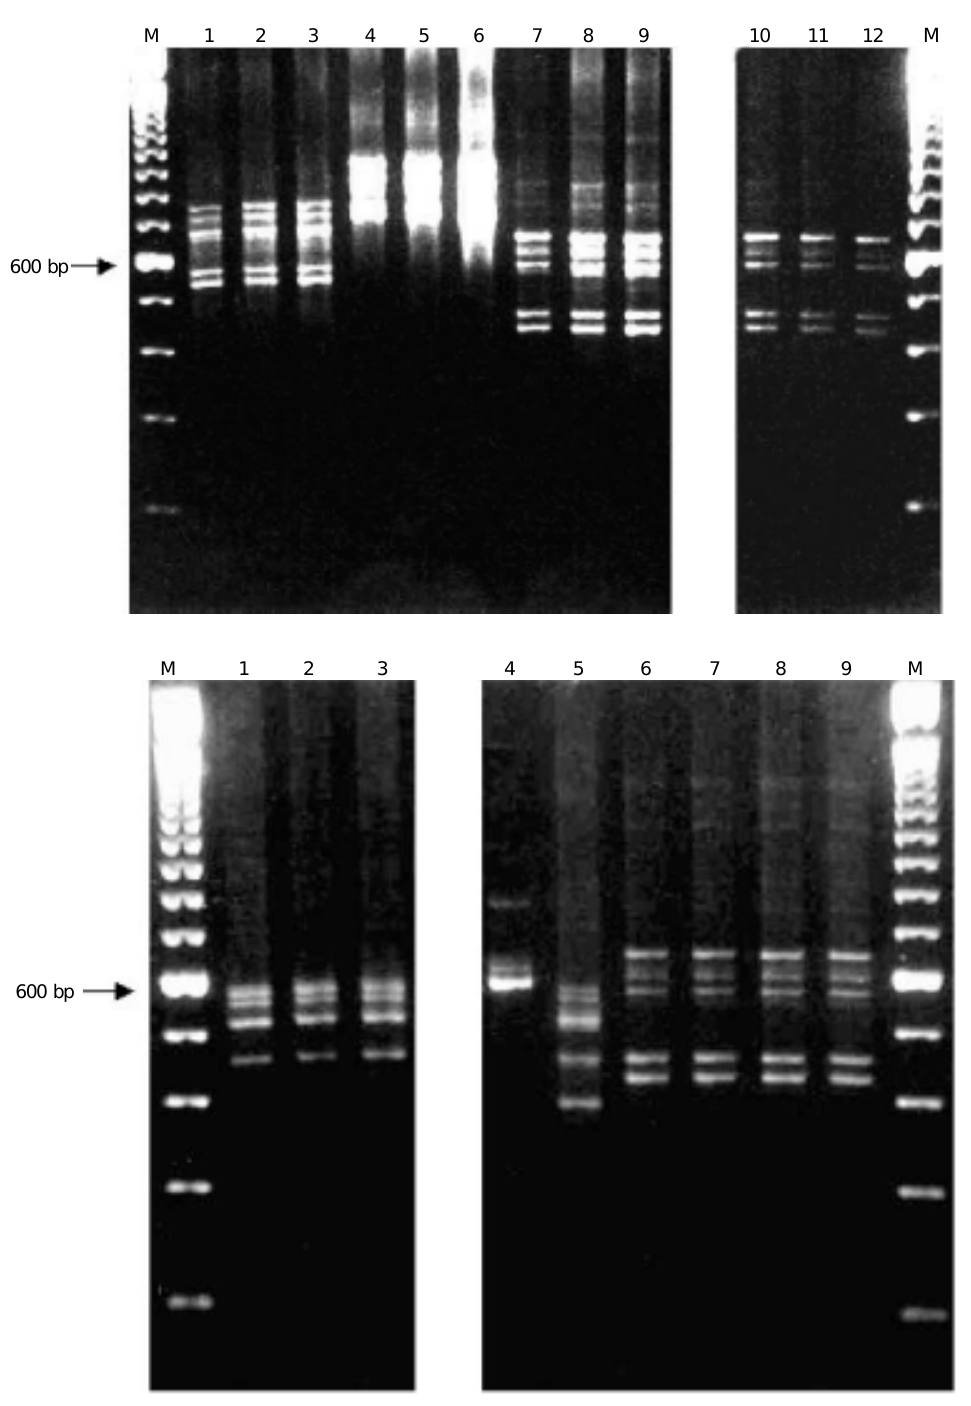
Figure 1. Electrophoretic pat- terns of PCR ribotypes of three S. aureus strains obtained with the three different primer pairs: lanes 1 to 3 with primer pair A, described by Gürtler and Stani- sich (5), lanes 4 to 6 with prim- ers B, described by Kostman et al. (3), and lanes 7 to 9 with prim- ers C, described by Jensen et al. (6). Lanes 10 to 12 show PCR ribotypes from three S. aureus isolates collected from the same patient on different days. Lane M: 100-bp ladder.